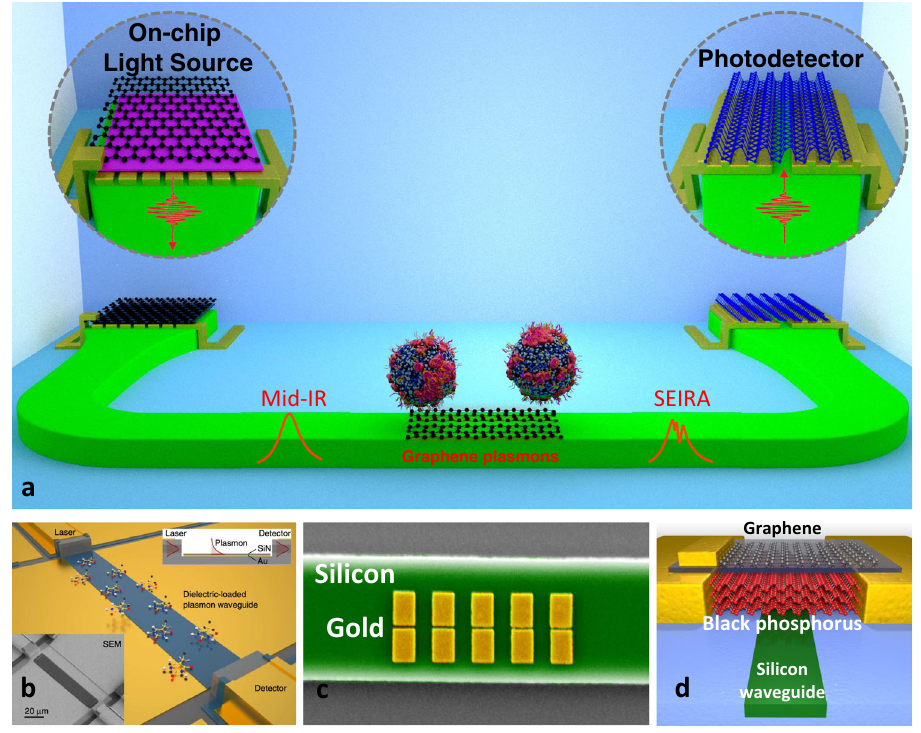
Fig. 5 Progress towards lab-on-a-chip detector systems. a Illustration of a waveguide-integrated hybrid nanophotonic biosensing platform. By harnessing excitons, plasmons, and phonon-polaritons in a wide range of vdW materials, we envision that researchers will be able to integrate light sources, mid-IR sensors, nano-tweezers, and detectors on a chip. Image credit: Daehan Yoo. b Monolithically integrated lab-on-a-chip chemical sensing platform based on a quantum cascade laser and detection coupled with a gold plasmonic waveguide. Reprinted from ref. 84 with permission. c Waveguide-integrated SEIRA sensor. Five pairs of gold nanorods with a 30-nm gap were patterned on a silicon waveguide for SEIRA sensing of molecular monolayers. Reprinted from ref. 85 with permission. d Waveguide-integrated black phosphorus